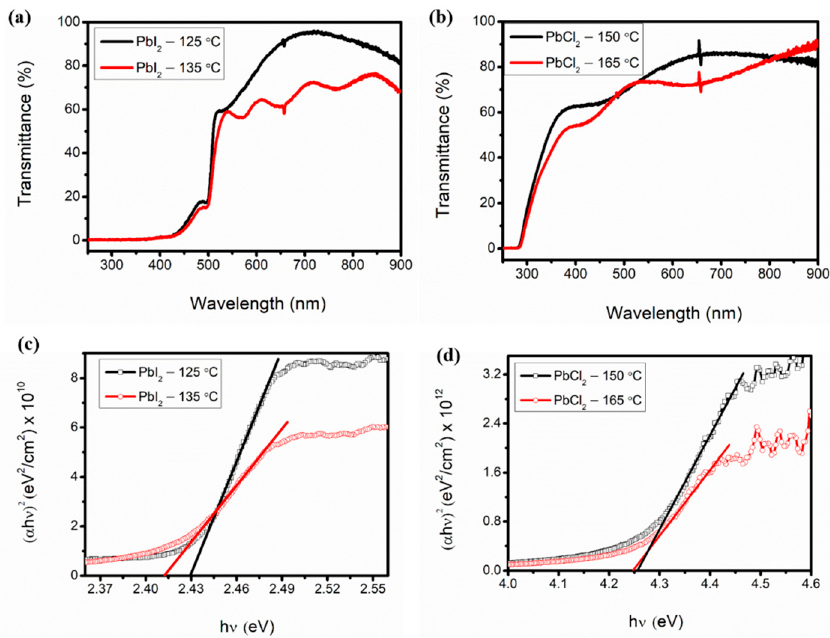
Figure 7. ( a ) UV–vis transmittance spectra of PbI 2 thin films on glass; ( b ) UV–vis transmittance spectra of PbCl 2 thin films on glass; ( c ) Tauc plots of PbI 2 films; and ( d ) Tauc plots of PbCl 2 films.